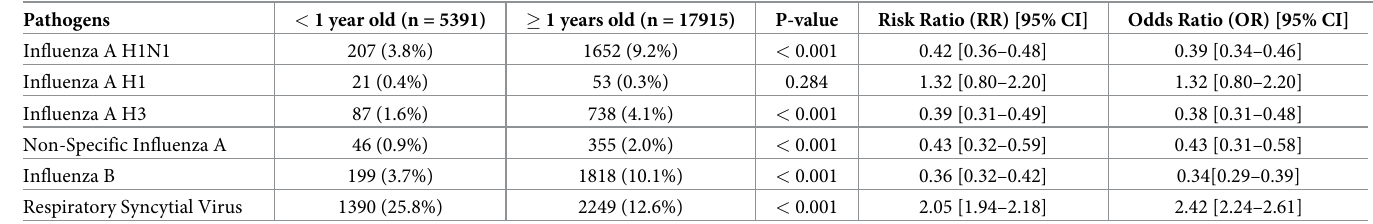
Table 3. Distribution of influenza A, influenza B and respiratory syncytial virus in different age group.